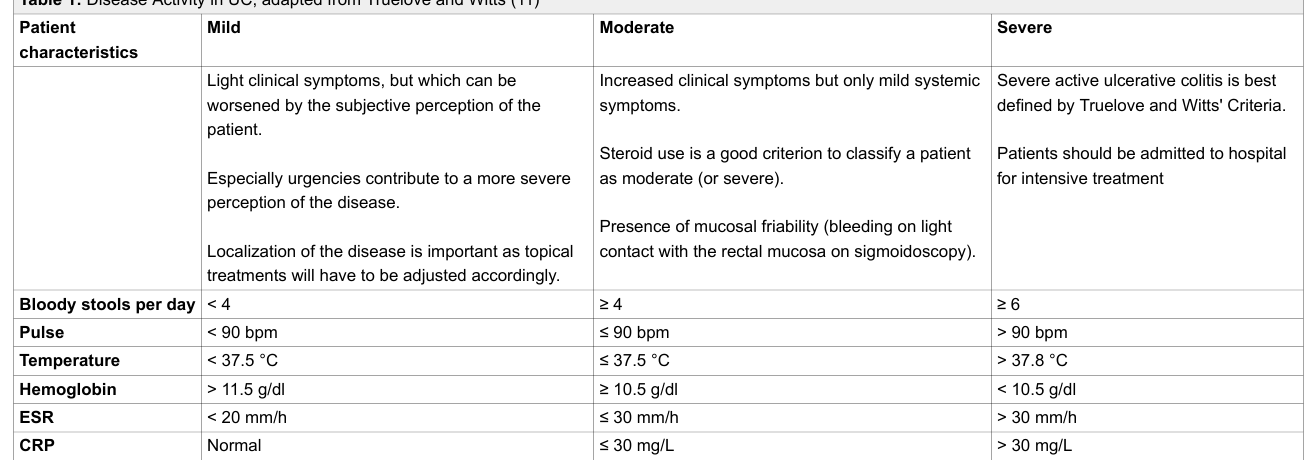
Table 1: Disease Activity in UC, adapted from Truelove and Witts (11) Patient